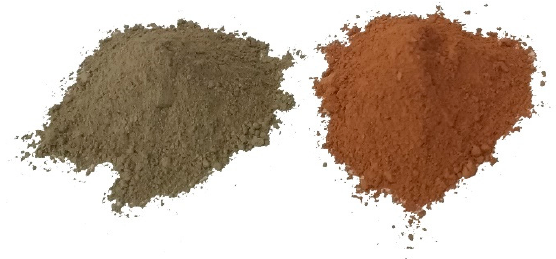
Figure 1. Untreated ( left ) and thermally treated ( right ) silts.